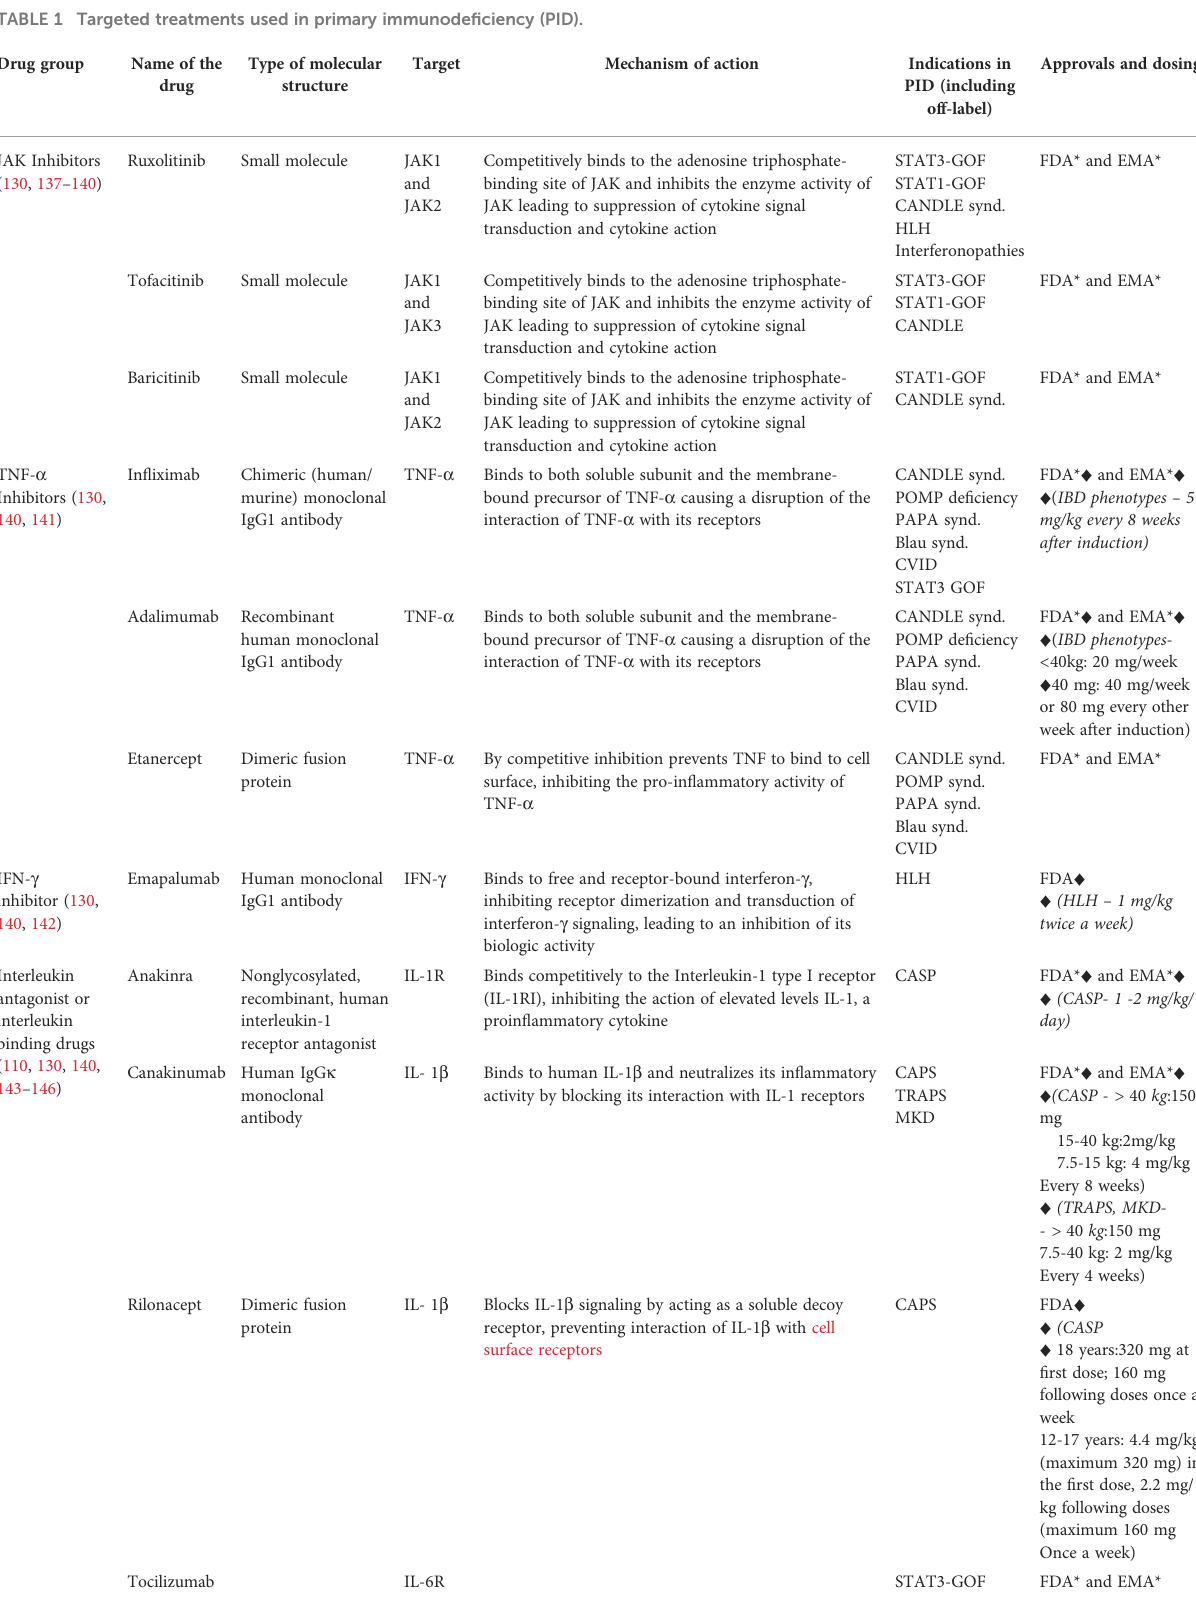
TABLE 1 Targeted treatments used in primary immunode fi ciency (PID). Drug